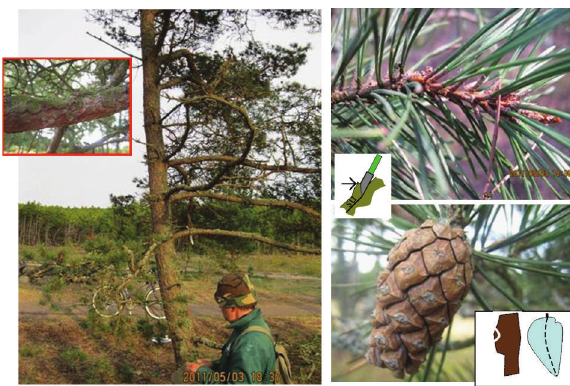
Figure 3: Putative P. sylvestris (female) × P. mugo (male) hybrid representing the hybrid group A (H S × M, Figure 5; Table 2; Id PD43). Left, two-stemmed, 12 meter tall (the other stem cut), bending at the base (like mugo ); upper stem bark dark brown ( sylvestris ), no paper flakes ( mugo ) but the fissures reddish brown ( sylvestris ); upper right: shoots brown ( sylvestris ), needles greyish green ( sylvestris ), stem unit tip does not bend backwards at the needle sack (sylvestris); lower right: cone apophysis glossy ( mugo ) without hook, that is, flat ( sylvestris ), umbo bordered ( mugo ), cone symmetric ( sylvestris